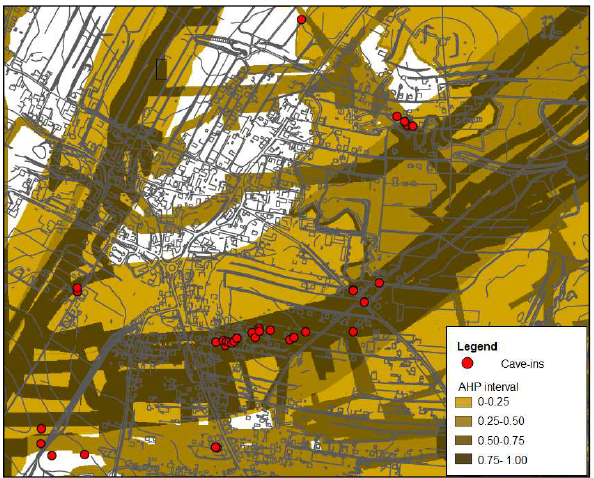
Figure 2. Depth of the mining panels.